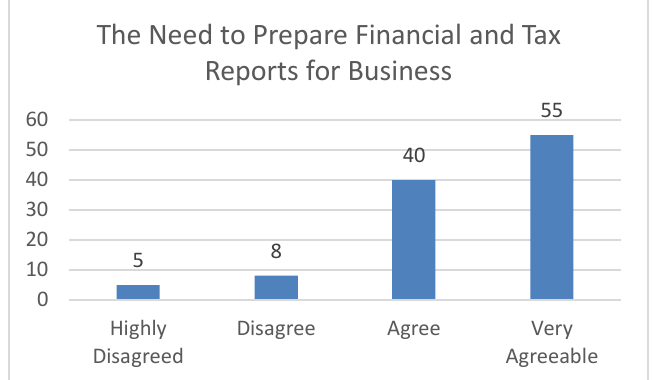
Figure 4: The Need to Prepare Financial and Tax Statements on Business; Source: Own